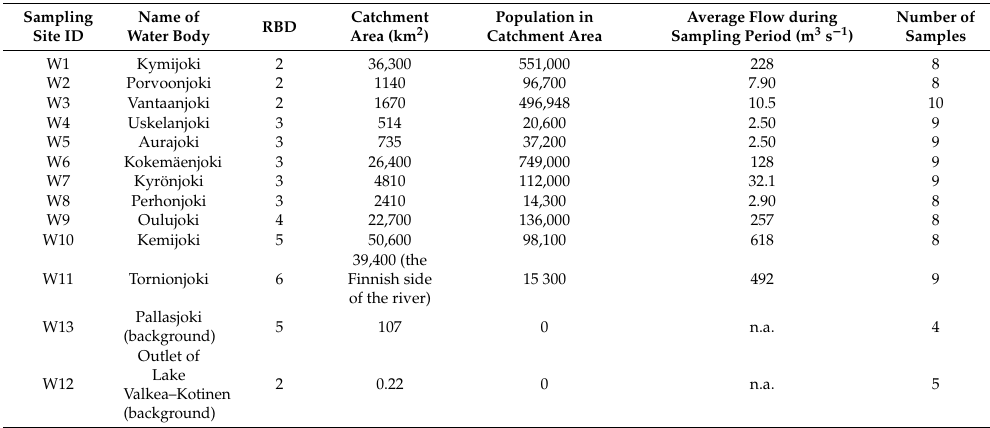
Table 2. Surface water sampling sites, their catchment areas, average flows during October 2016 and August 2017 and number of samples per